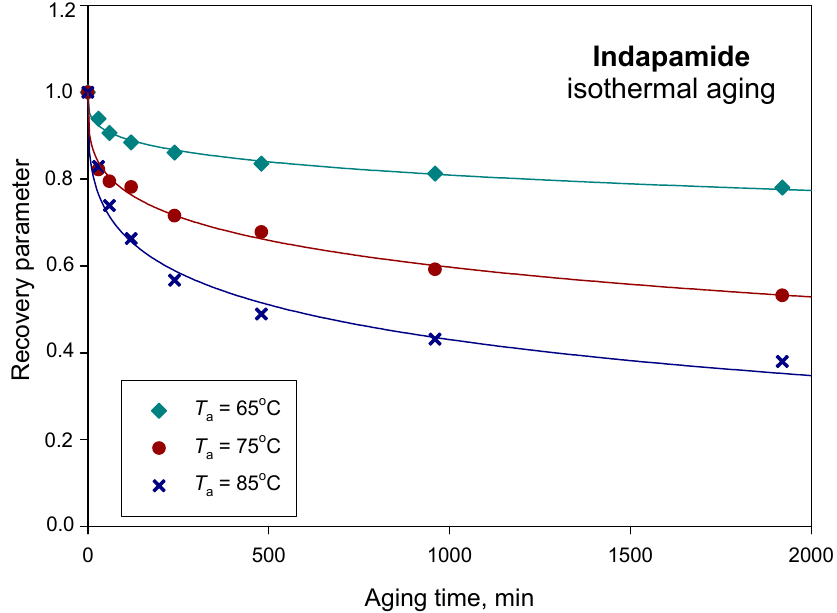
Figure 8. Recovery parameter as a function of the ageing time for amorphous indapamide aged at 65, 75 and 85 °C.